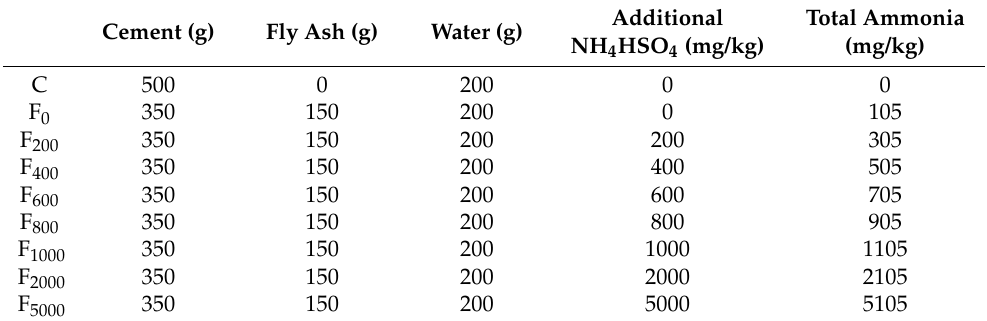
Table 3. Compound ratios used to prepare samples with different NH 4 HSO 4 concentrations. Cement (g) Fly Ash (g) Water